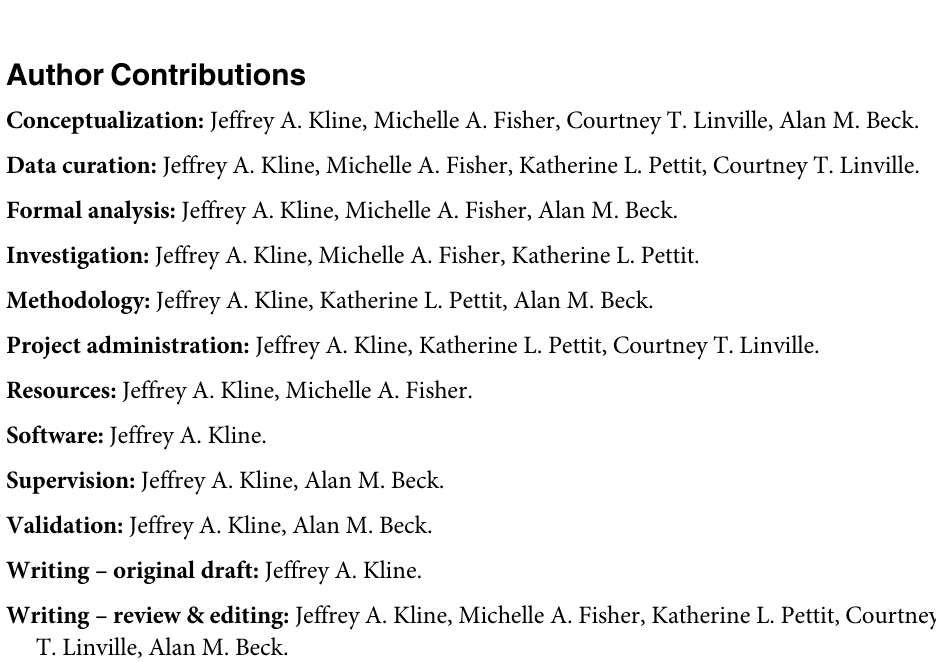
S3 Table. P values for pain scores. S4 Table. Performance of each therapy dog and